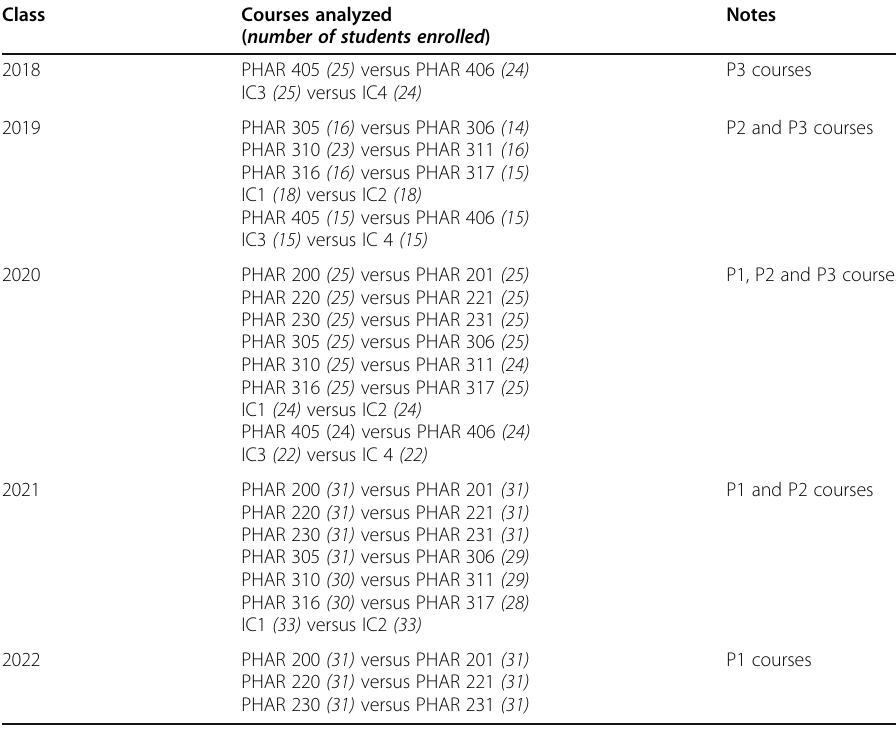
Table 2 Courses analyzed per cohort of students Class Courses analyzed ( number of students enrolled